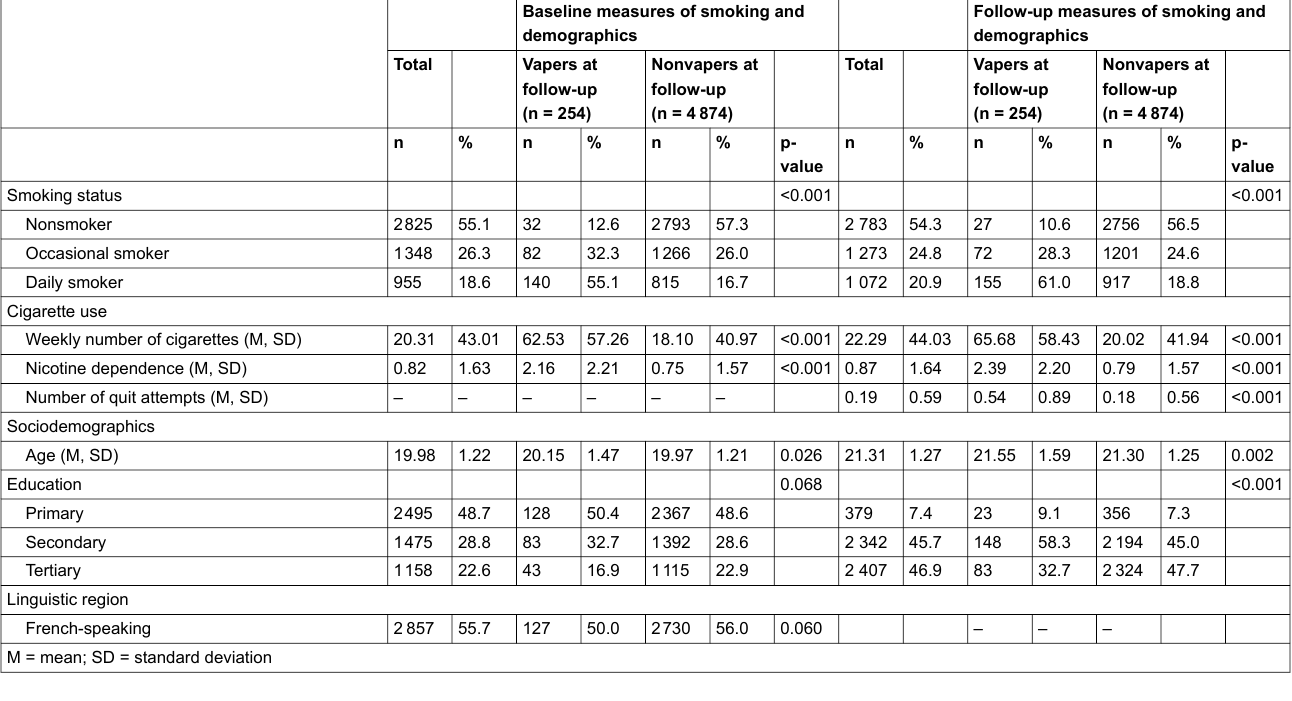
Table 1: Descriptive characteristics at baseline and follow-up of the total sample and of vapers and nonvapers (measured at follow-up only), Switzerland 2010–2013.